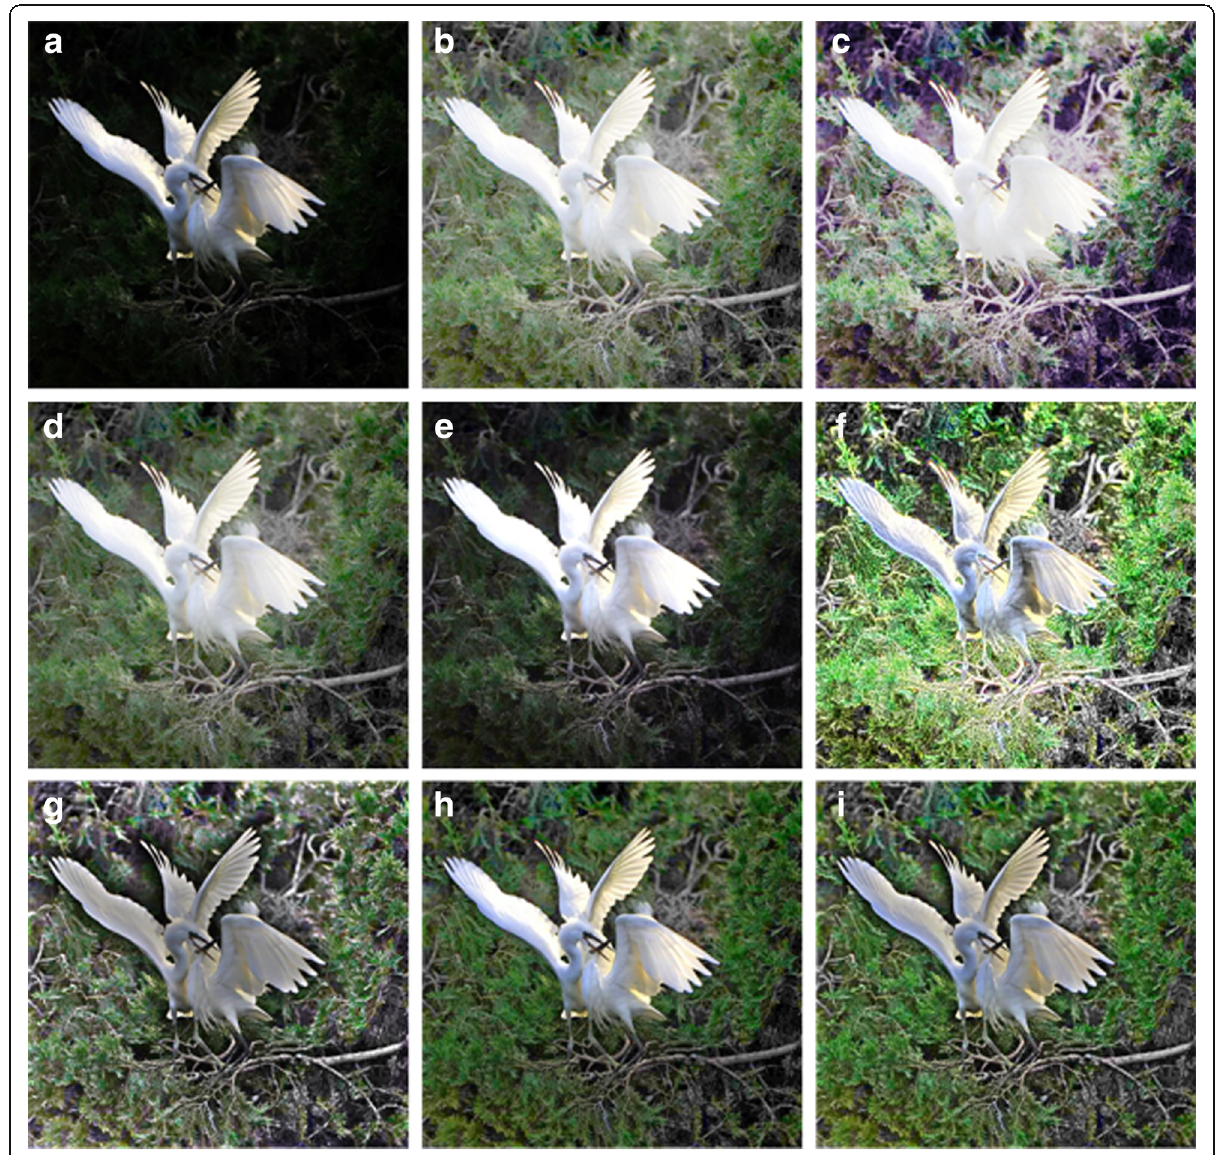
Fig. 7 Experimental results on bird. a Original image; b MSR; c LHE; d AL; e ALTM; f GUM; g SARV; h NPE; i